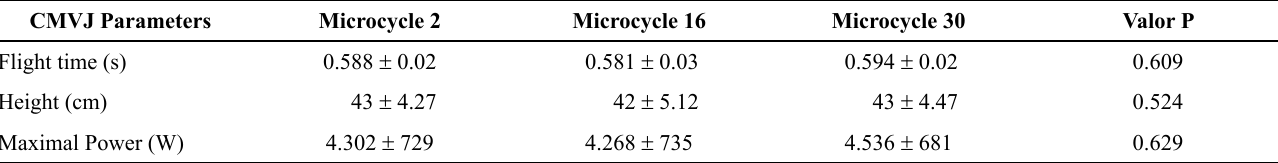
5. Characteristics of CMVJ performed by basketball players on a force platform in three different moments of the training